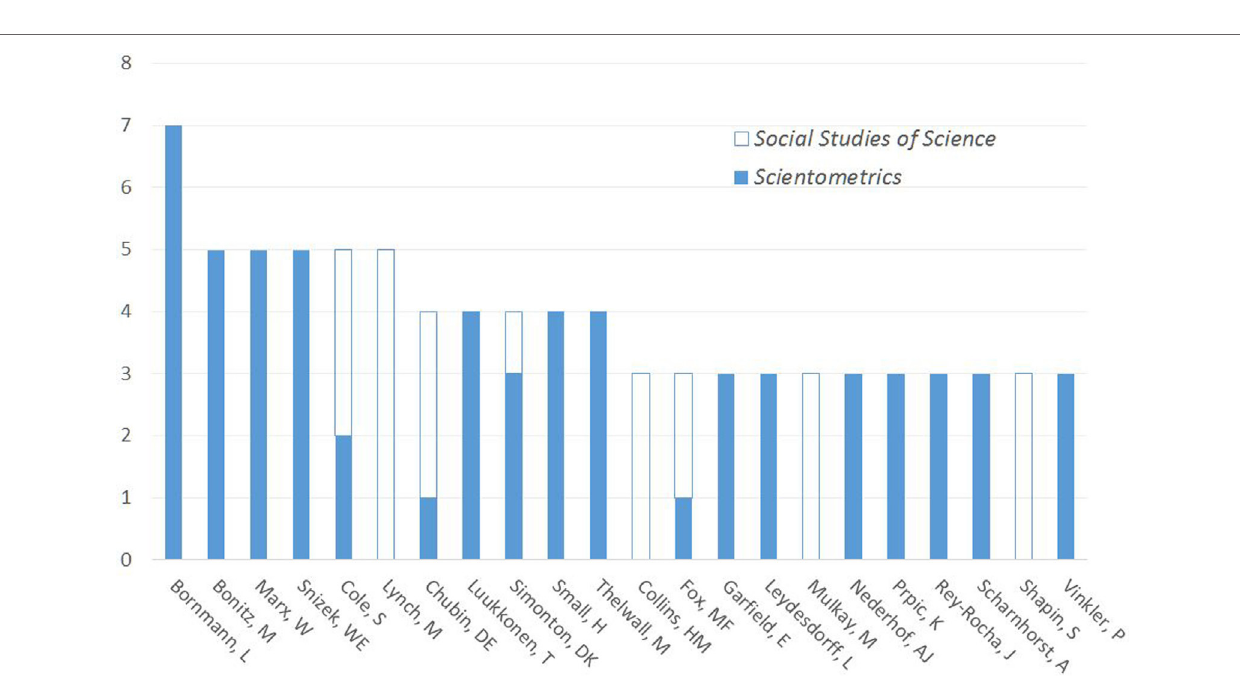
FigUre 7 | eighty-five publications of twenty-two authors citing Merton as a first author (more than twice) in Scientometrics and Social Studies of Science